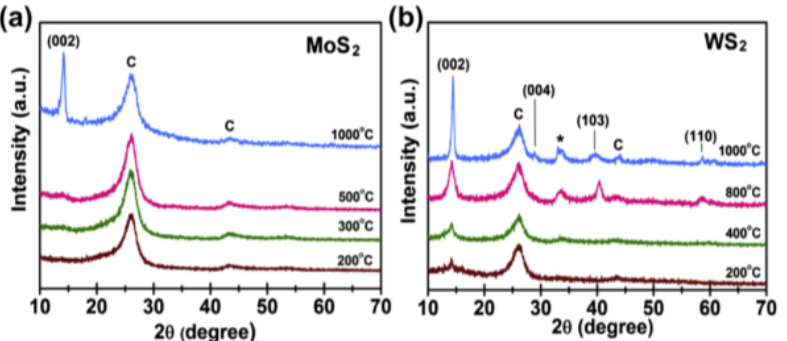
Figure 14. XRD pattern for the samples obtained at different thermolysis temperatures: ( a ) MoS 2 on carbon cloth and ( b ) WS 2 on carbon cloth. Peaks with notation C represent the carbon peaks from carbon cloth. (*) indicates the peaks from WO 3 . Reproduced with permission from